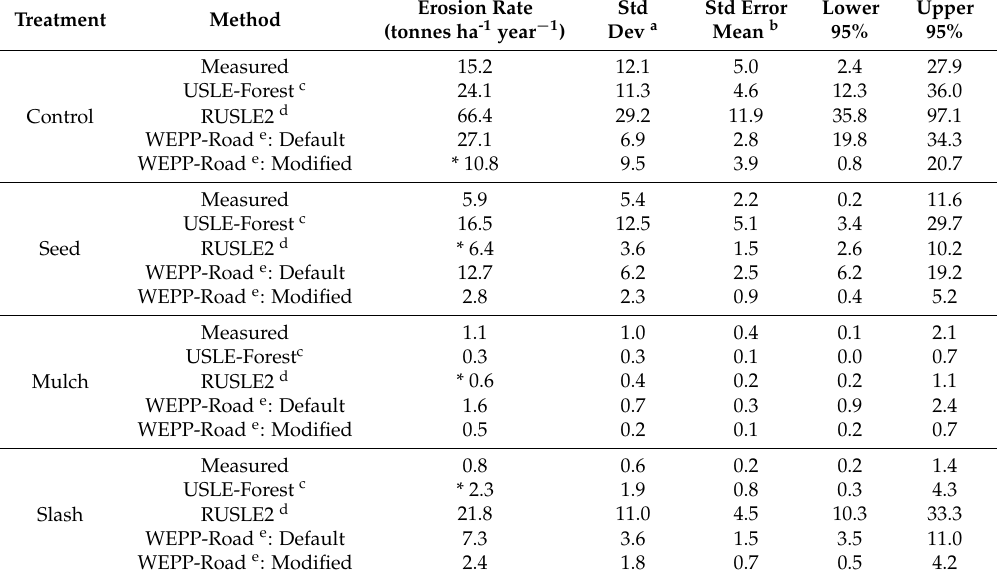
Table 1. Summary statistics for each of the models analyzed. For each treatment, there is an asterisk (*) next to the model prediction that is closest to the measured amount.